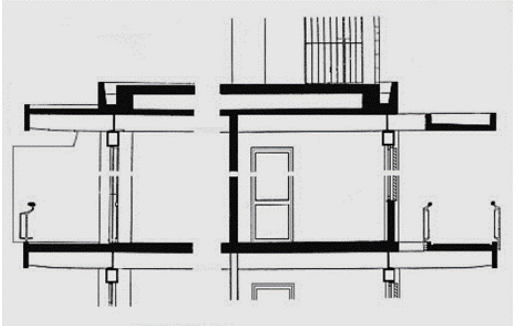
Figure 7. Section of the last floor.